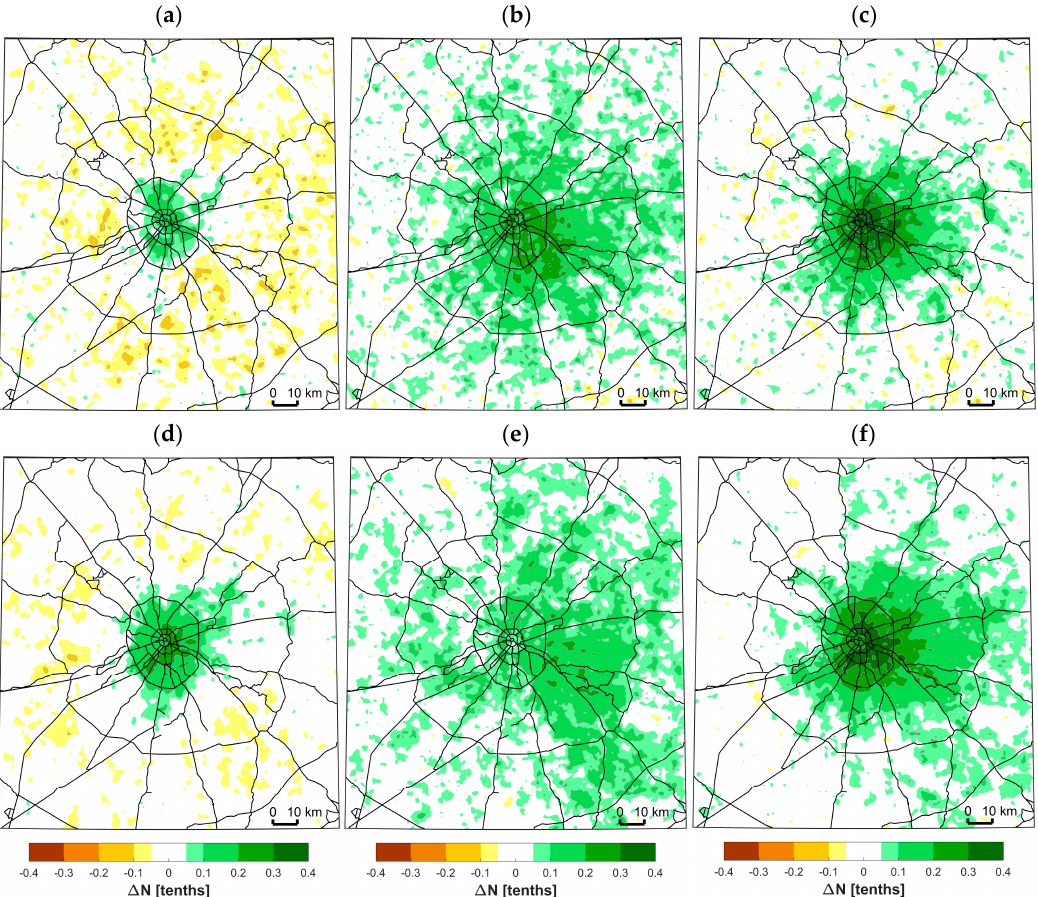
Figure 12. Modeled response of the: low ( a , d ); middle and high ( b , e ); and total ( c , d ) cloud cover to switching on the urban canopy model ( ∆ N in tenths, where total cloud cover is 10) averaged over daytime (12–14 UTC/15–17 MSK) and evening (15–17 UTC/18–20 MSK) hours for 10 summer seasons (2007–2016).